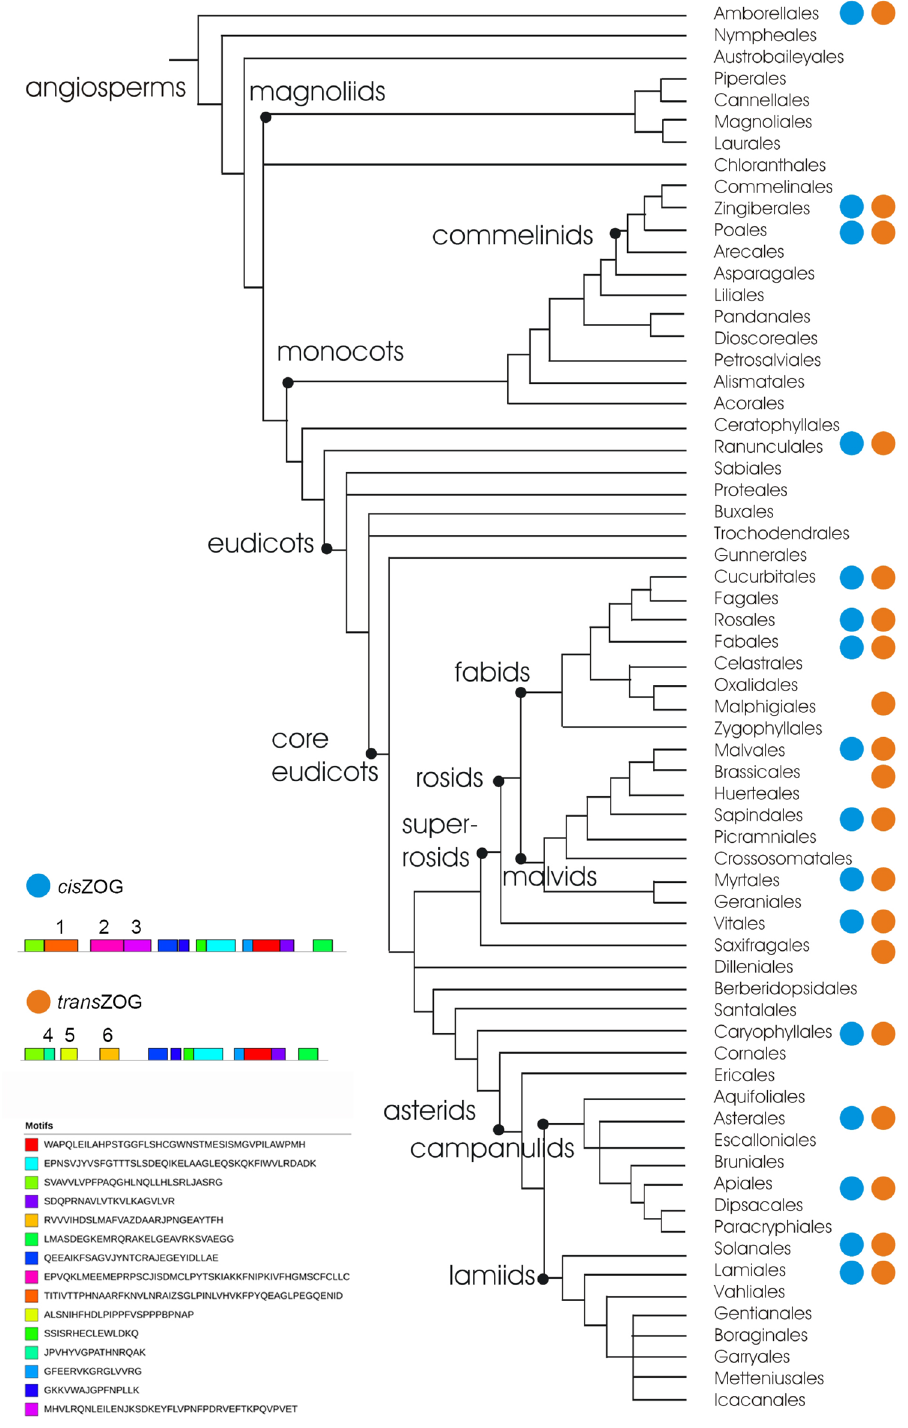
Figure 1. Simplified consensus phylogenetic tree of angiosperms adapted from APG IV. (2016) showing groups where cis - or trans ZOG were found (based on Phytozome v12) and typical sequence motifs for them. Cis ZOG contains conserved motifs 1,2 and 3, trans ZOG 4, 5 and